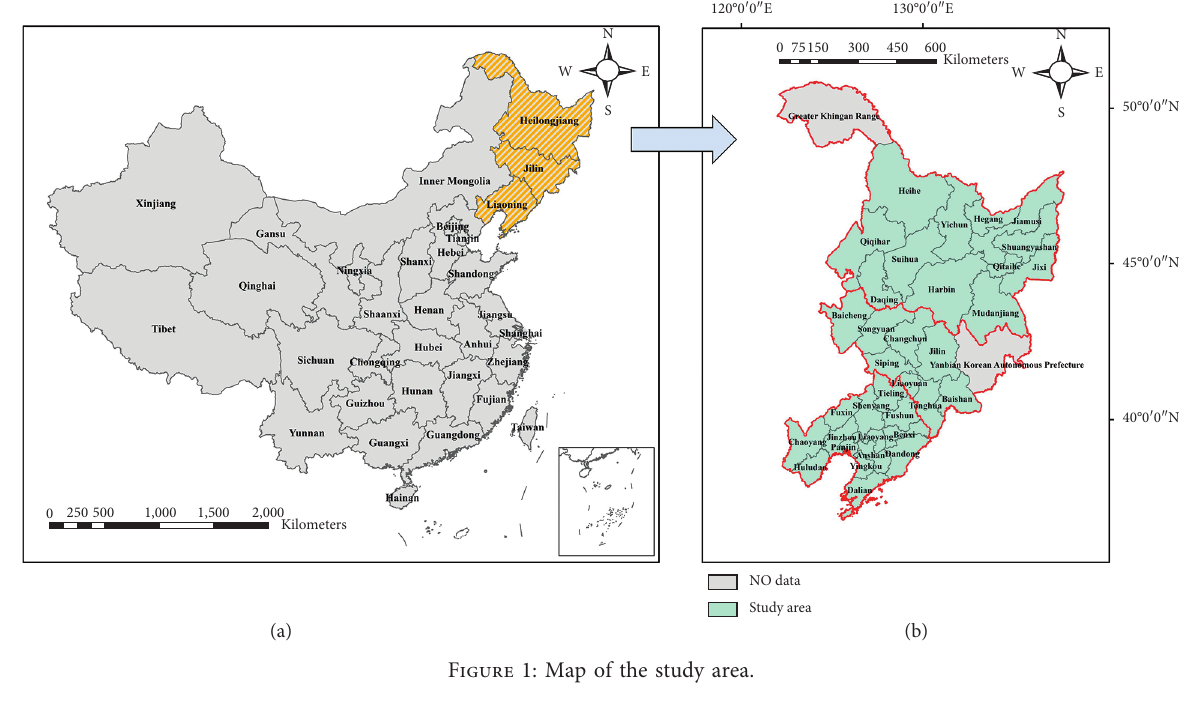
Figure 1: Map of the study area.